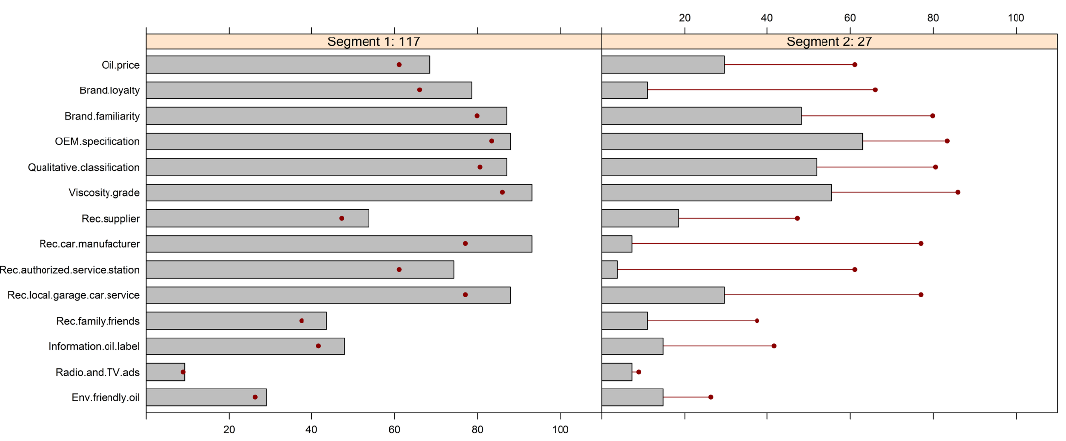
Figure 1. Results of model-based clustering (2 segments).